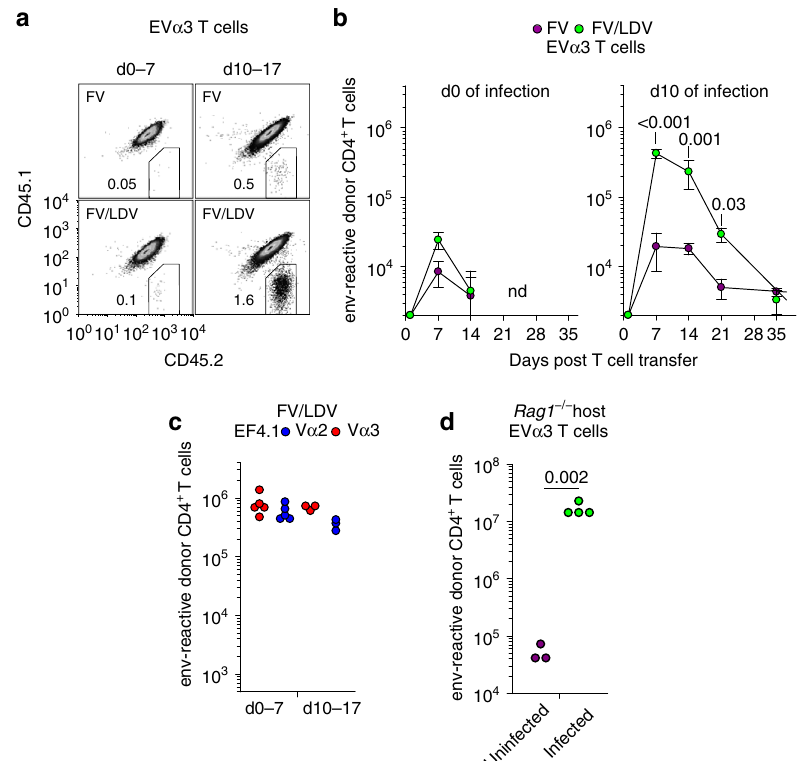
Figure 6 | Asynchronous expansion of higher- and lower-avidity clonotypes. ( a ) Flow cytometric detection of CD45.2 þ donor EV a 3 Rag1 (cid:2) / (cid:2) Emv2 (cid:2) / (cid:2) CD4 þ Tcells and CD45.1 þ CD45.2 þ host CD4 þ Tcells following transfer either on the day of infection (d0 of infection, d0–7) or 10 days after infection (d10 of infection, d10–17) with FV or FV/LDV. In both setups, T-cell expansion was analysed 7 days after transfer ( n ¼ 5–9). ( b ) Absolute number of env-reactive donor EV a 3 CD4 þ T cells recovered from the spleens of the same recipients described in a over the course of FV infection or FV/LDV coinfection (nd, not detected). ( c ) Absolute number of V a 2 or V a 3 env-reactive donor EF4.1 CD4 þ Tcells recovered from the spleens of FV/LDV infected recipients 7 days after transfer either on the day of infection (d0–7) or 10 days after infection (d10–17). ( d ) Numbers of EV a 3 Tcells recovered 7 days after transfer from the spleens of lymphocyte-deficient Rag1 (cid:2) / (cid:2) Emv2 (cid:2) / (cid:2) recipients that were either left uninfected or were F-MLV-B-infected. Each symbol represents an individual